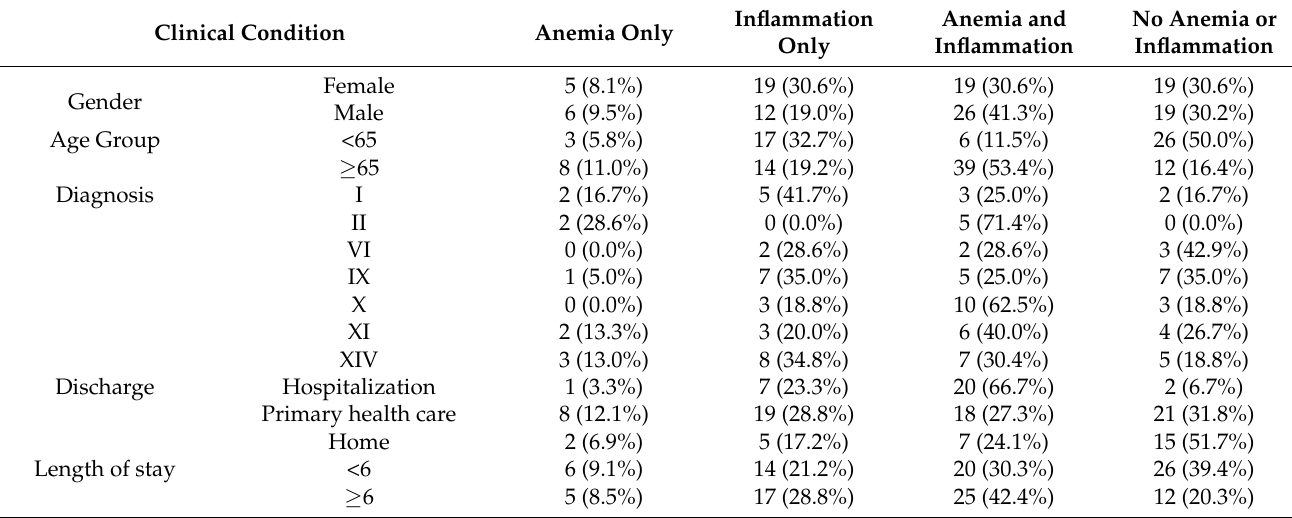
Table 2. Distribution of clinical conditions (anemia only, inflammation only, both anemia and inflammation, and neither of these) across each group of the